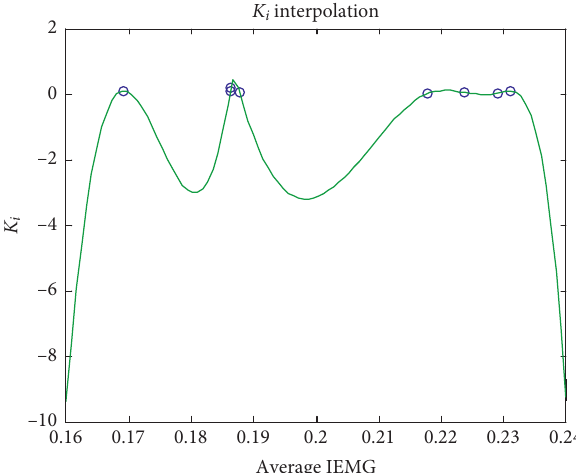
Figure 13: K i interpolation with “spline”